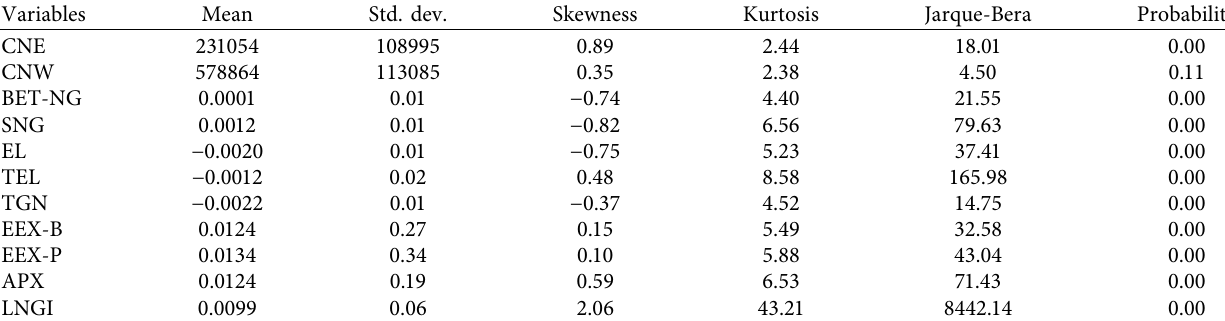
Table 3: Descriptive statistics of the